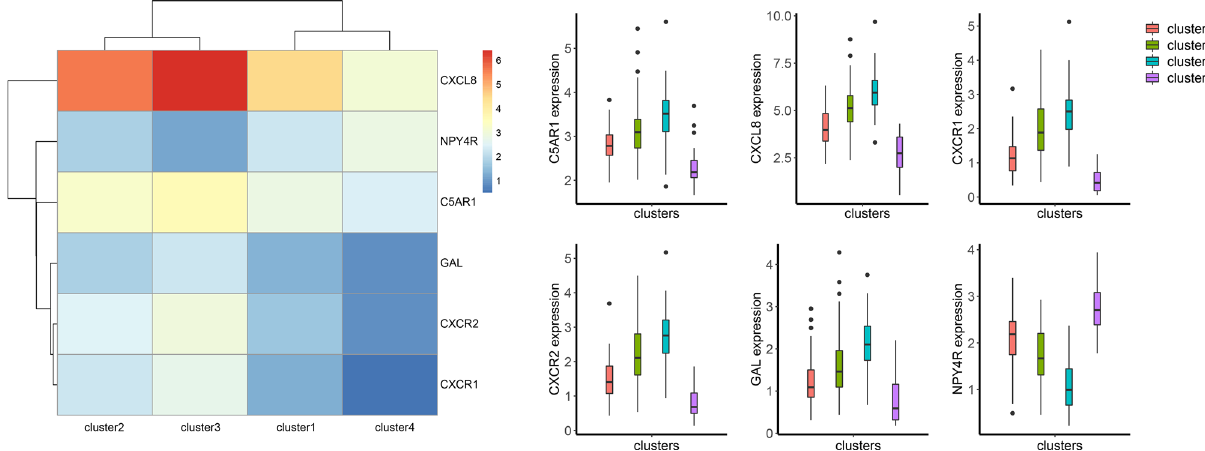
Figure 7. The expression heat map and expression level of 6 hub genes in different clusters, the heat map is made by R package pheatmap (https ://cran.r-proje ct.org/web/packa ges/pheat